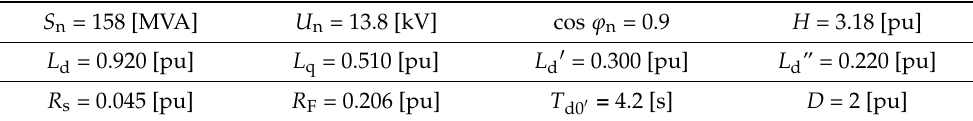
Table A3. Manufacturer’s data: hydro-type synchronous generator S n = 158